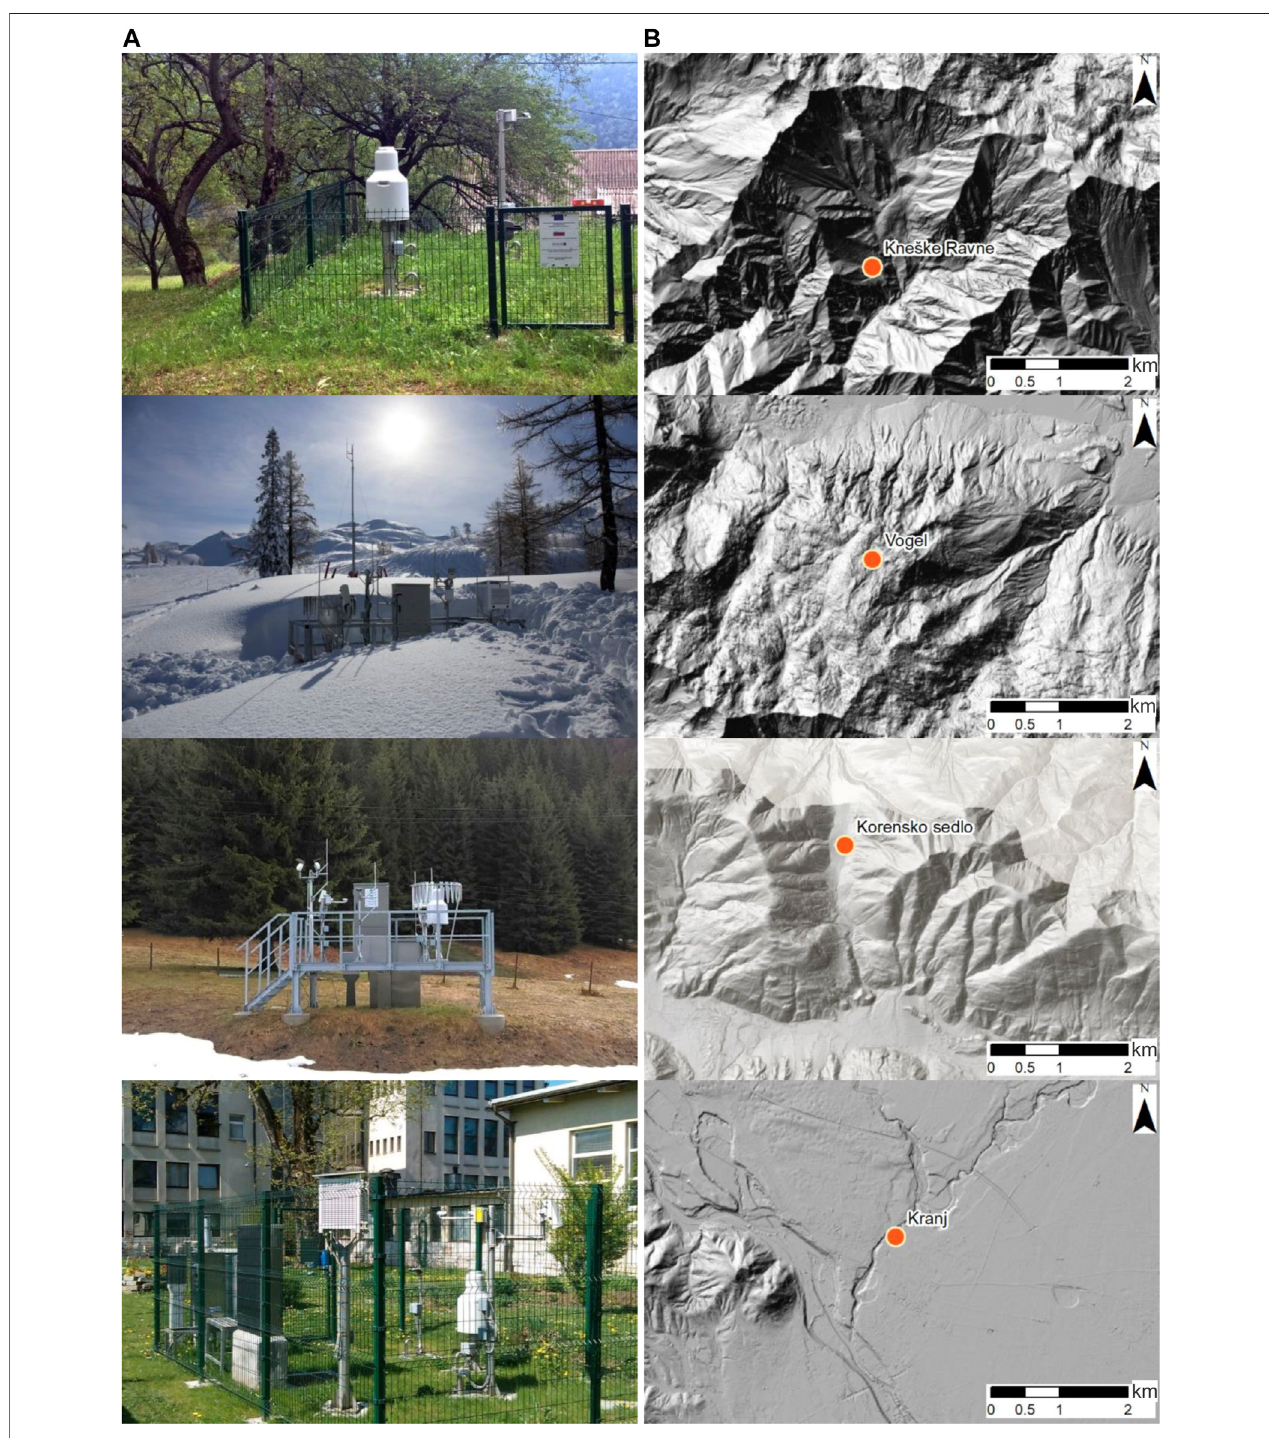
FIGURE 2 | Photos of Kne š ke Ravne, Vogel, Korensko sedlo, and Kranj meteorological stations (A) and their location on a hillshade map (B) . Hillshade source: Lidar Hillshade (http://gis.arso.gov.si/arcgis/rest/services/Lidar_hillshade/MapServer/WMTS) and Elevation/World_Hillshade (http://services.arcgisonline.com/arcgis/